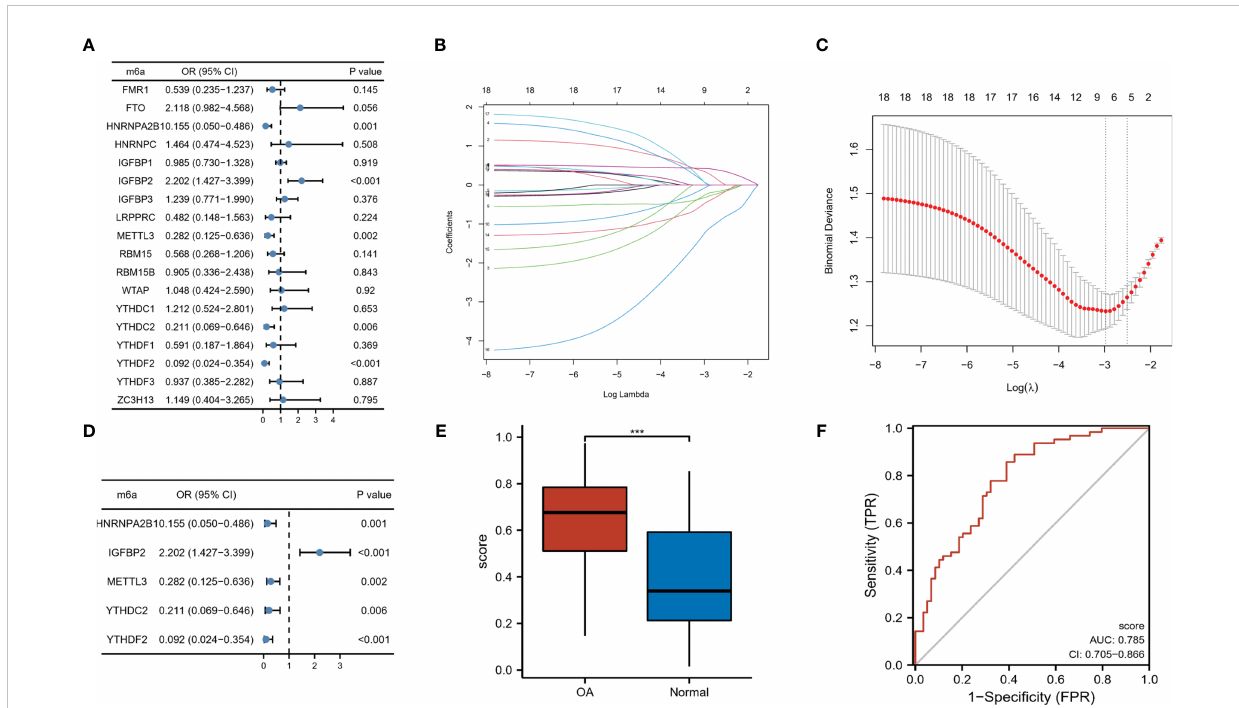
FIGURE 2 m6A regulators were linked with the OA process. (A) Five m6A regulators showed close correlations with the occurrence of OA through univariate logistic regression (P < 0.05). (B) LASSO coef fi cient pro fi les of the fi ve OA-related m6A regulators. (C) In LASSO regression 10-fold cross-validation